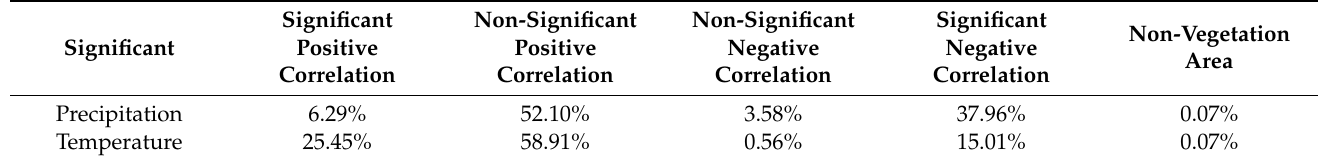
Figure 7. Significance test of the partial correlation coefficient between NDVI with annual average precipitation: ( a ) and annual average temperature; ( b ) in the Yangtze River Basin from 2000 to 2019. Table 5. Correlation statistics of NDVI with precipitation and